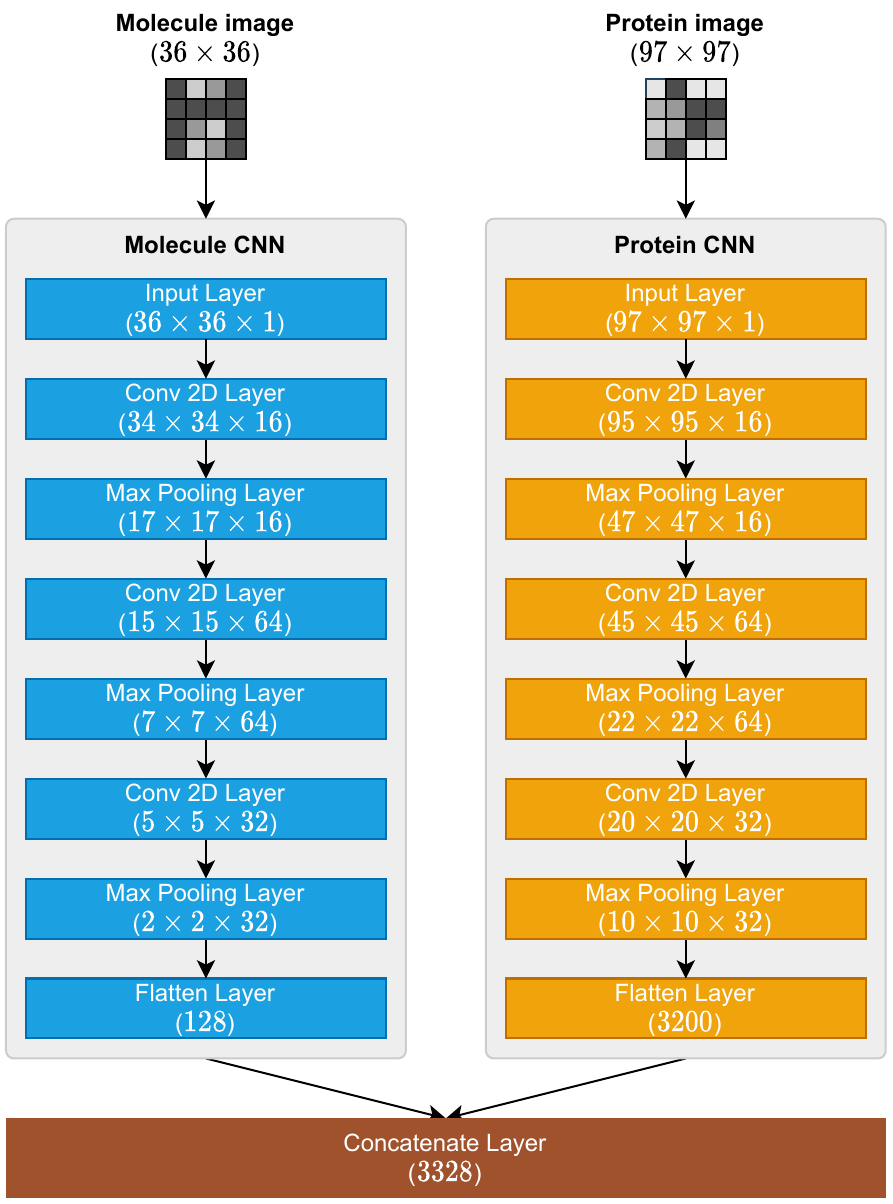
Figure 6. Molecule and protein CNNs, their layers, and the concatenate